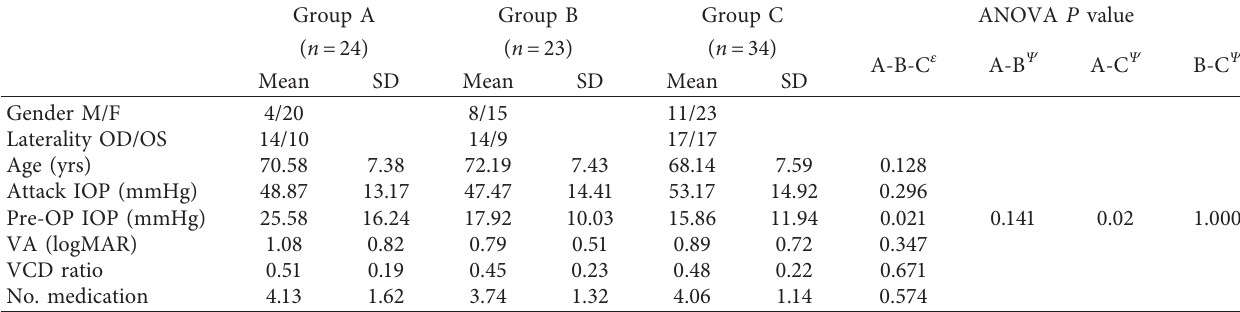
Table 1: Patient demographics and preoperative ocular